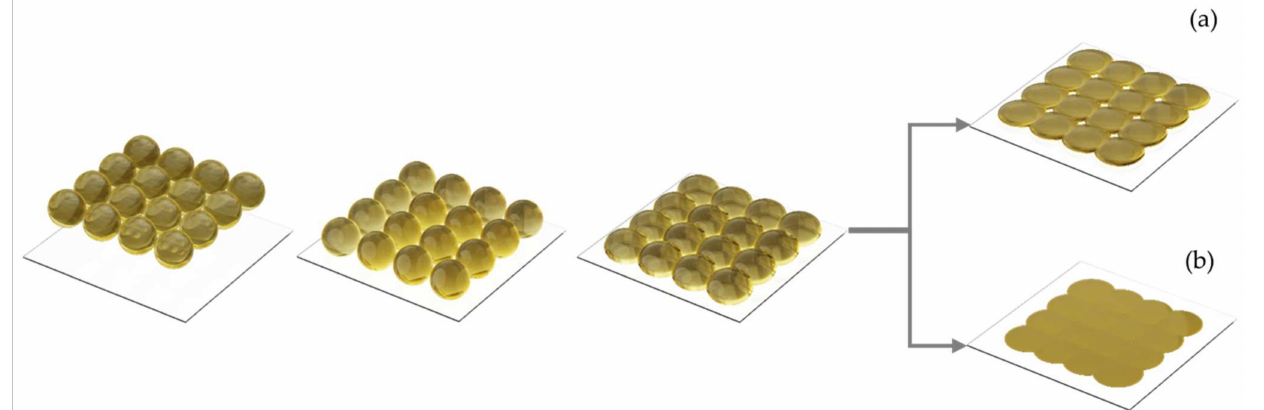
Figure 5. Illustration coalescence sequence of an array of drops leading to ( a ) with holes and a planar surface, and ( b ) without